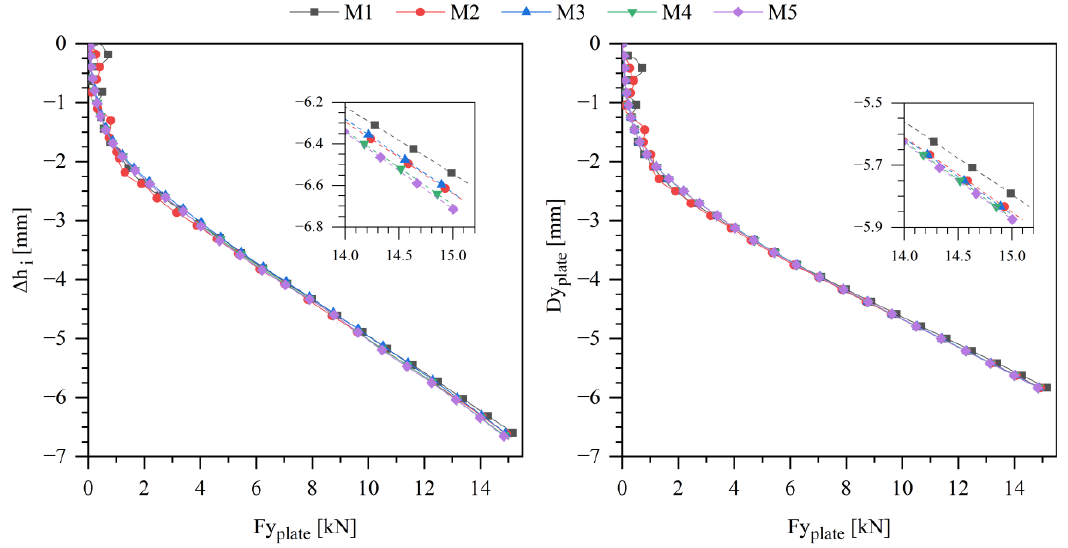
Figure 11. Inner toe cap y-variation and top plate y-displacement plot over plate y-force, for compression simulation. Figure 12 exhibits the effect of mesh refinement over the inner toe cap wall displace- ment as a function of the striker velocity in the y -direction. A tendency for convergence in the maximum ∆ h i value when the impact stops (Uy = 0 m/s) is noticed. Moreover, the M5 mesh predictions are similar to the ones for M4 mesh. A difference of 0.13 mm is seen between the M1 and M5 for the final ∆ h i , which indicates that the cell crossover at the initial time steps just affect the compression simulation, on the impact counterpart there are no visible effect.